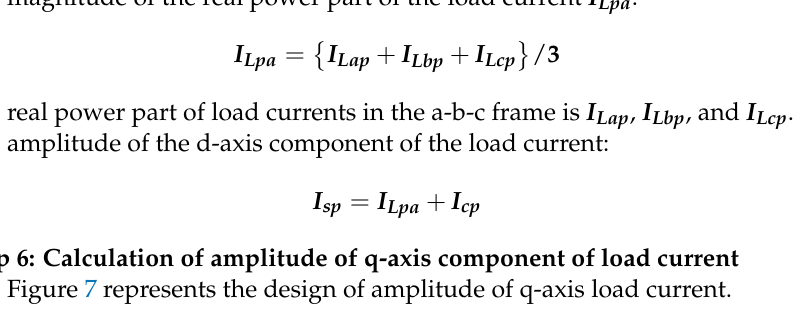
6 Figure 5. Design of 𝑰𝑰 𝑳𝑳𝒂𝒂𝒂𝒂 and 𝑰𝑰 𝑳𝑳𝒂𝒂𝒂𝒂 . Step 5: Calculation of amplitude of the d-axis component of load current The Figure 6 represents the design of amplitude of d-axis load current.